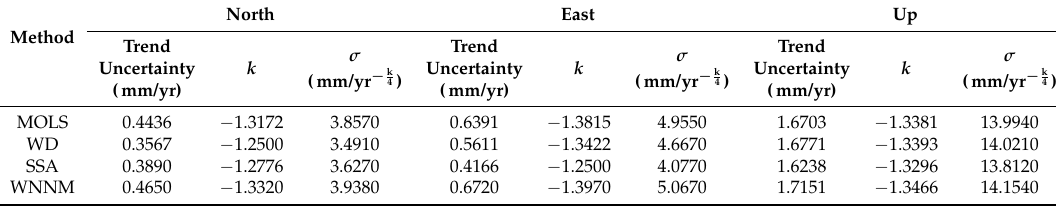
Figure 8. GNSS coordinate time series before and after pre-processing for BJFS and TNML stations. ( a ) The series which has been interpolated (red line), and the original series (black line) is also plotted; ( b ) Two GNSS time series, where red line represents the time series after the outliers have been removed and black line represents the original time series. Table 6. Results of trend uncertainty, spectral index and noise amplitude estimated from the GNSS time series of BJFS station under different